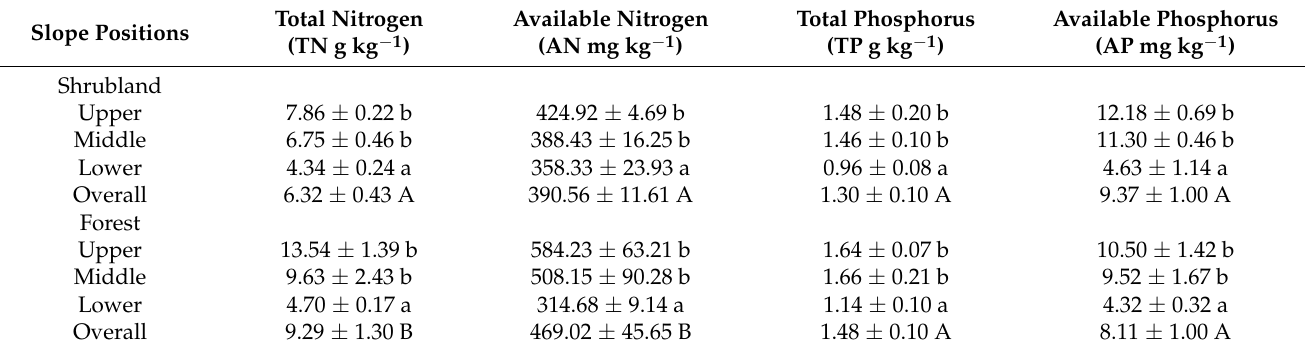
Table 2. Soil nitrogen (N) and phosphorus (P) concentrations and availabilities in two vegetations of a karst ecosystem (mean ±